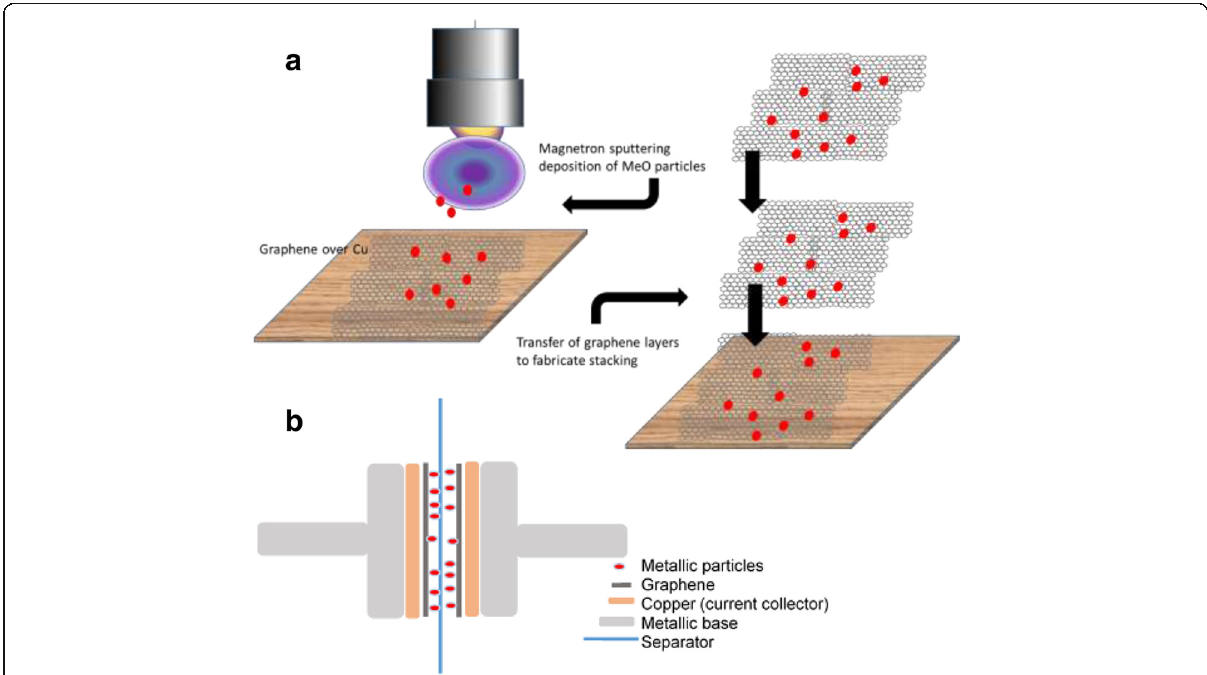
Fig. 1 Schematic drawings. Detailed legend: a Schematic drawing showing the preparation process of the graphene/MeO stacking. b Scheme of the design of the cell. The separator (glass fiber filter) is soaked with 1 M LiClO4 dissolved in ethylene carbonate (EC) and diethyl carbonate (DEC) mixed in 1:1 volumetric